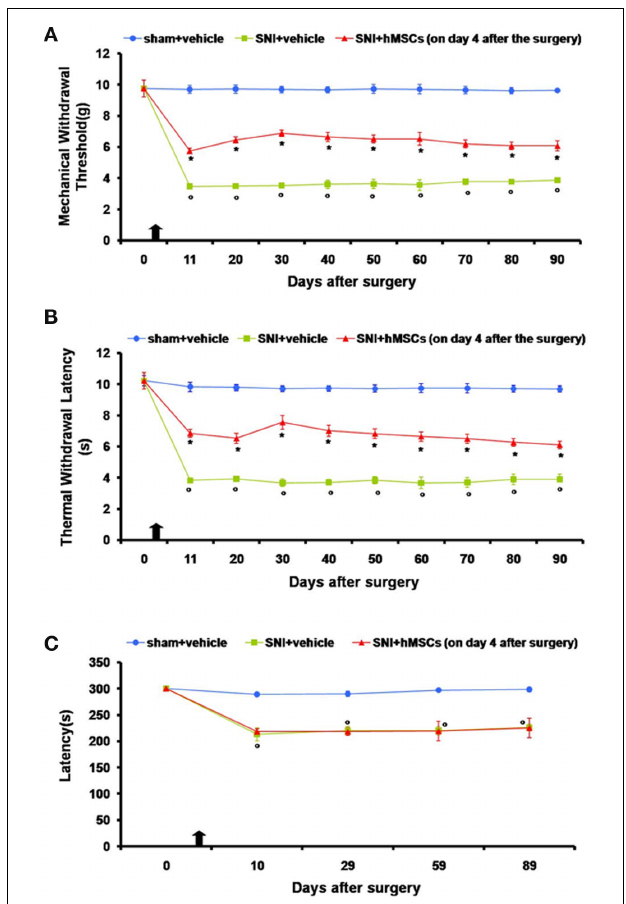
FIGURE 1 | (A) Effects of human mesenchymal stem cells on reflex withdrawal responses (g, mean ± SEM) to mechanical noxious stimuli in SNI mice.The onset of SNI-induced mechanical allodynia was evaluated in ipsilateral sides every 10days starting from day 11 until 90days after surgery. Mice showed a significant reduction in the threshold to mechanical stimulation in the ipsilateral paw (* p < 0.05 vs. sham-operated mice) after SNI surgery. Human MSC treatment (on day 4 after SNI surgery, as indicated by the arrow) prevented the appearance of mechanical allodynia at 11, 20, 30, 40, 50, 60, 70, 80, and 90days post-SNI (˚ p < 0.05 vs. SNI mice). (B) Effects of human mesenchymal stem cells on reflex withdrawal responses (s, mean ± SEM) to thermal noxious stimuli in SNI mice.The onset of SNI-induced thermal hyperalgesia was evaluated in ipsilateral sides every 10days starting from day 11 until 90days after surgery. SNI mice showed a significant reduction in withdrawal latency to radiant heat in the ipsilateral paw (* p < 0.05 vs. sham-operated mice). Human MSC treatment (on day 4 after SNI surgery, as indicated by the arrow) prevented the appearance of thermal hyperalgesia 11, 20, 30, 40, 50, 60, 70, 80, and 90days post-SNI (˚ p < 0.05 vs. SNI mice). (C) Rotarod motor testing results. The effects of human mesenchymal stem cell injection on motor performance in the Rotarod test is shown. Systemic administration of hMSCs in tail vein of SNI mice had no effect on motor function compared with vehicle treated SNI mice. Human MSCs were injected on day 4 after the SNI surgery. Results are expressed as the mean ± SEM of the latency (s; n = 5 mice/group). * p < 0.05 vs. sham/vehicle.